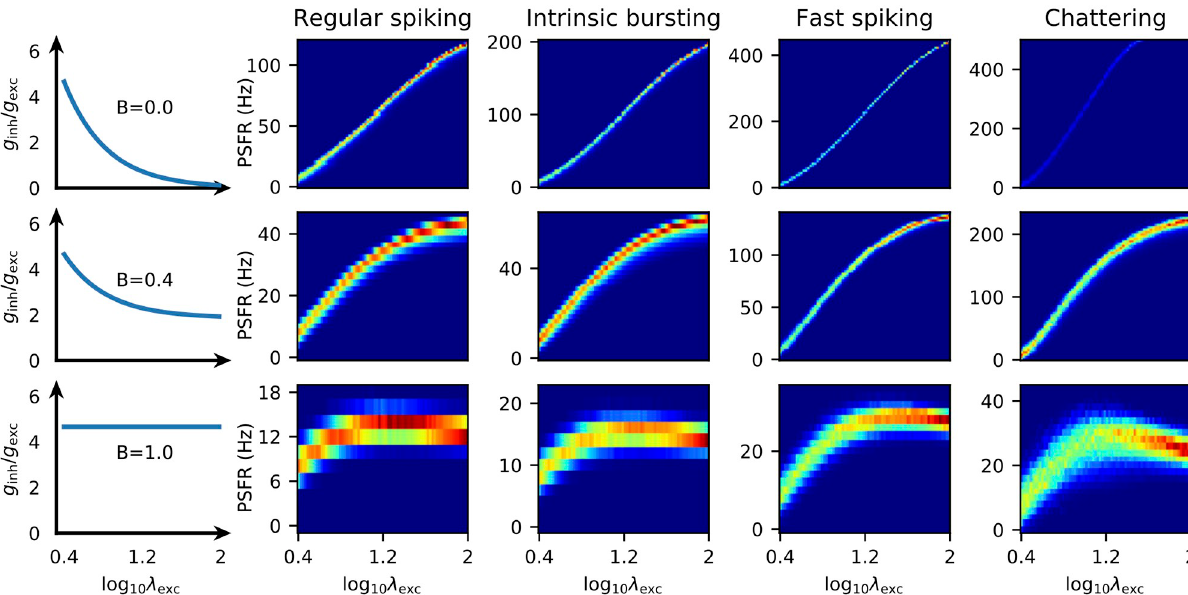
Fig 2. Stimulus-response relationships. Stimulus-response relationships for the MAT neurons specified by the parameters in Table A in S1 Appendix. Each row corresponds to a different inhibition regime. The ratio of inhibitory to excitatory conductance as a function of stimulus intensity is displayed in the leftmost column. The time window Δ was in this case chosen as 500 ms. The x -axis is logarithm of the rate of bombardment by excitatory synapses (Eq 23). The y -axis shows the post-synaptic firing rate (Eq 21). The rate of inhibitory synapses is specified by B (Eq 24). This Figure is also available with equally scaled y -axes for all neurons and regimes (S1